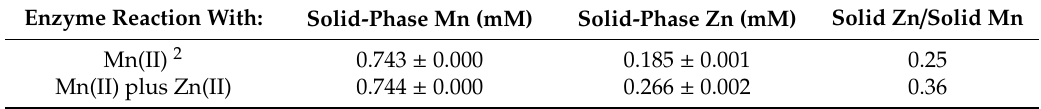
Table 1. Sorption of Zn(II) on Mn oxides produced by recombinant Mco1 1 . Enzyme Reaction